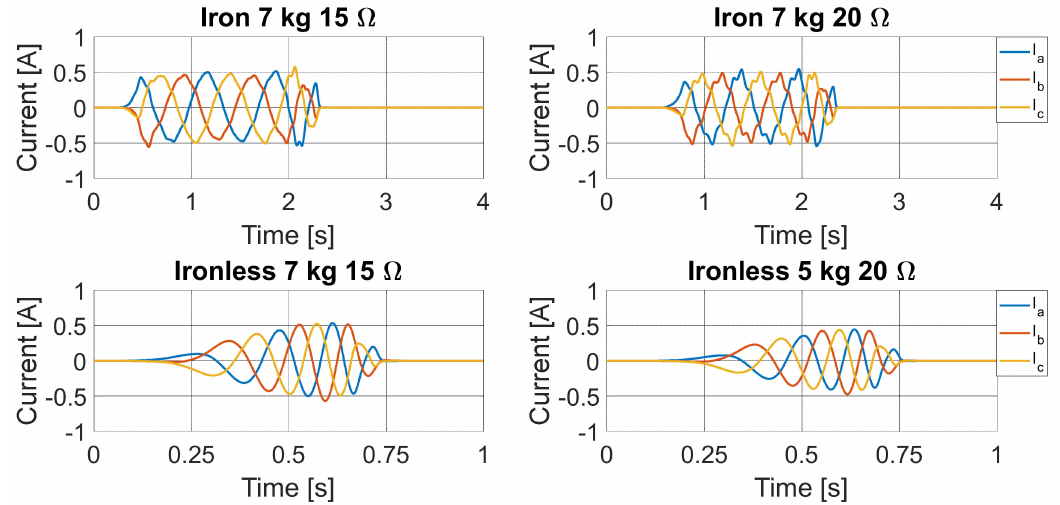
Figure 18. Load currents trends of the 7 kg test with a resistance load equal to 15 Ω and 20 Ω